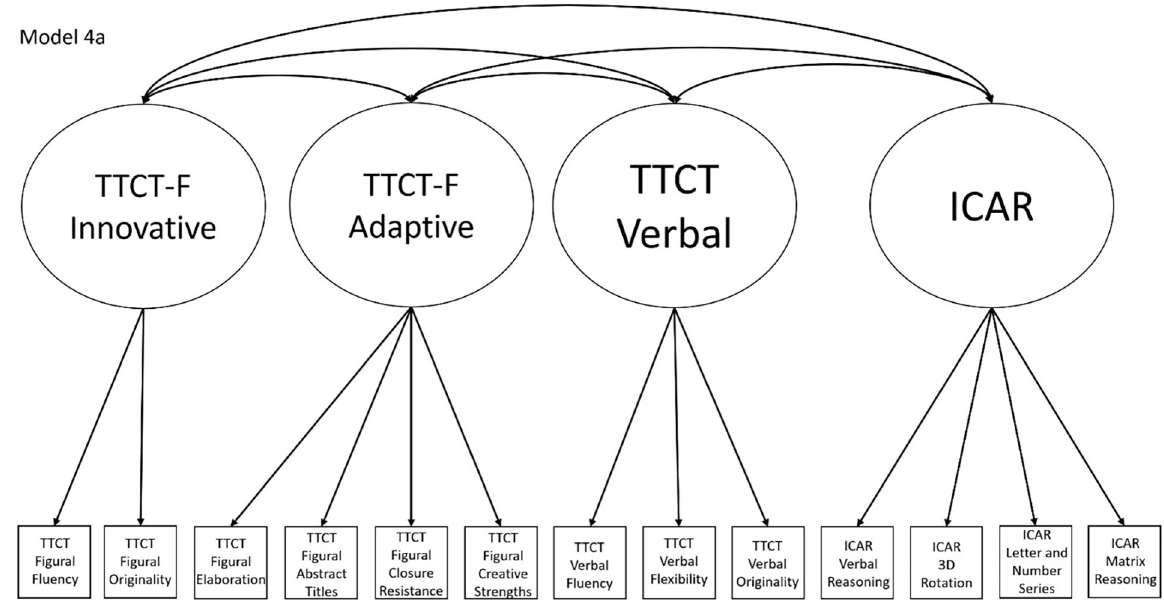
Fig 5. Confirmatory factor analysis diagram for model